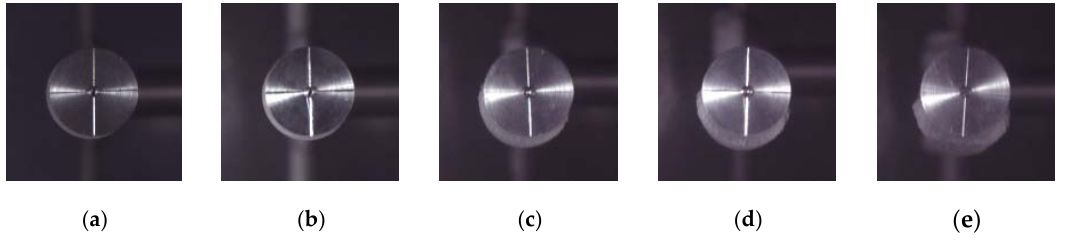
Figure 17. Icing on a cylinder rotating around the horizontal axis: ( a ) 100 rpm; ( b ) 200 rpm; ( c ) 400 rpm; ( d ) 600 rpm; ( e ) 800 rpm.